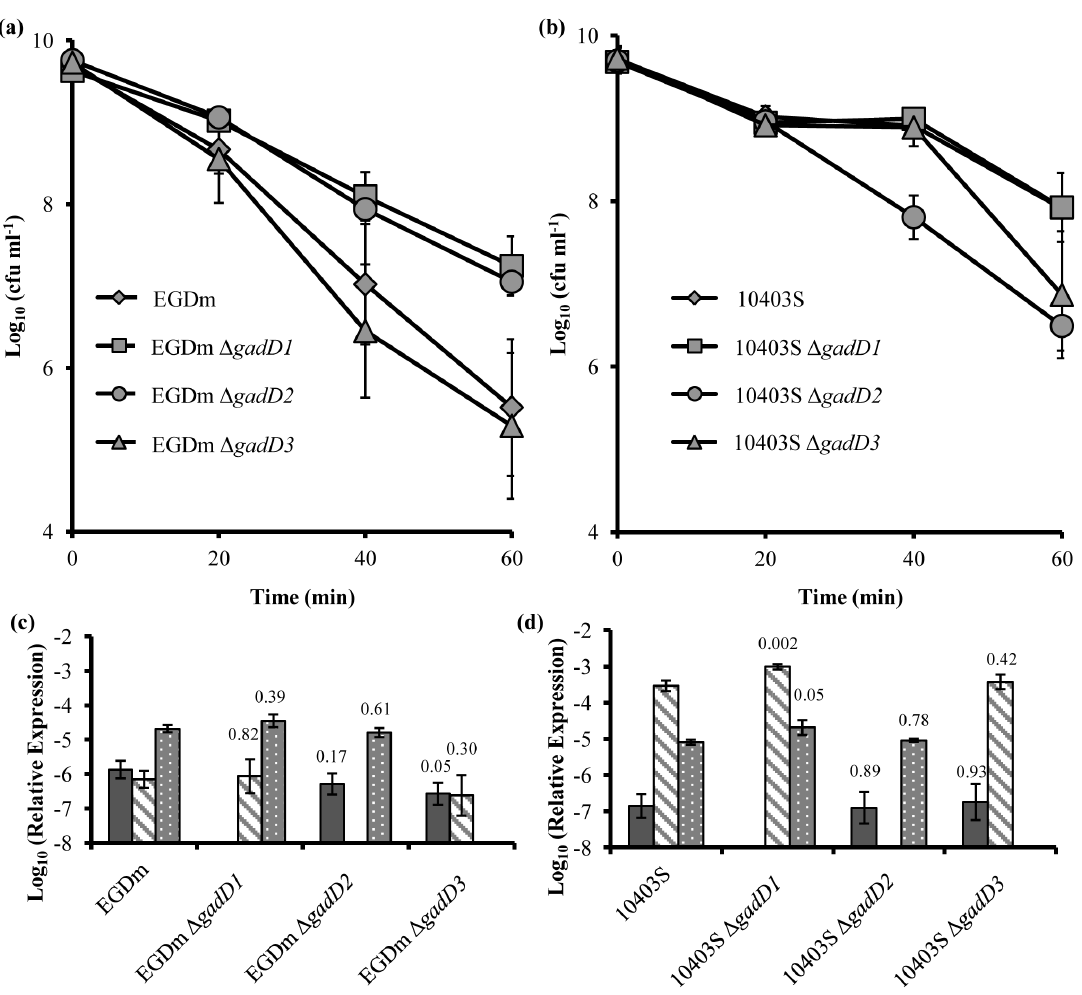
Figure 2. Acid survival of L.monocytogenesgad mutants. Stationary phase EGDm ( a ) and 10403S ( b ) D gad mutants were challenged at pH 2.5. Cell counts were taken every 20 min. Values are the means of data from three individual cultures, with the cell counts for each culture being the means of counts from three platings. Relative transcript levels of EGDm (c) or 10403S ( d ) gadD1 (dark grey fill), gadD2 (hatched) and gadD3 (grey) genes to 16S gene prior to acid exposure in each mutant strain. Error bars represent the standard error from the mean value of three individual biological repeats. The numbers over the bar charts ( c & d ) indicate the p -value for the difference between each gene expression compared to wild- type levels as determined by student’s t